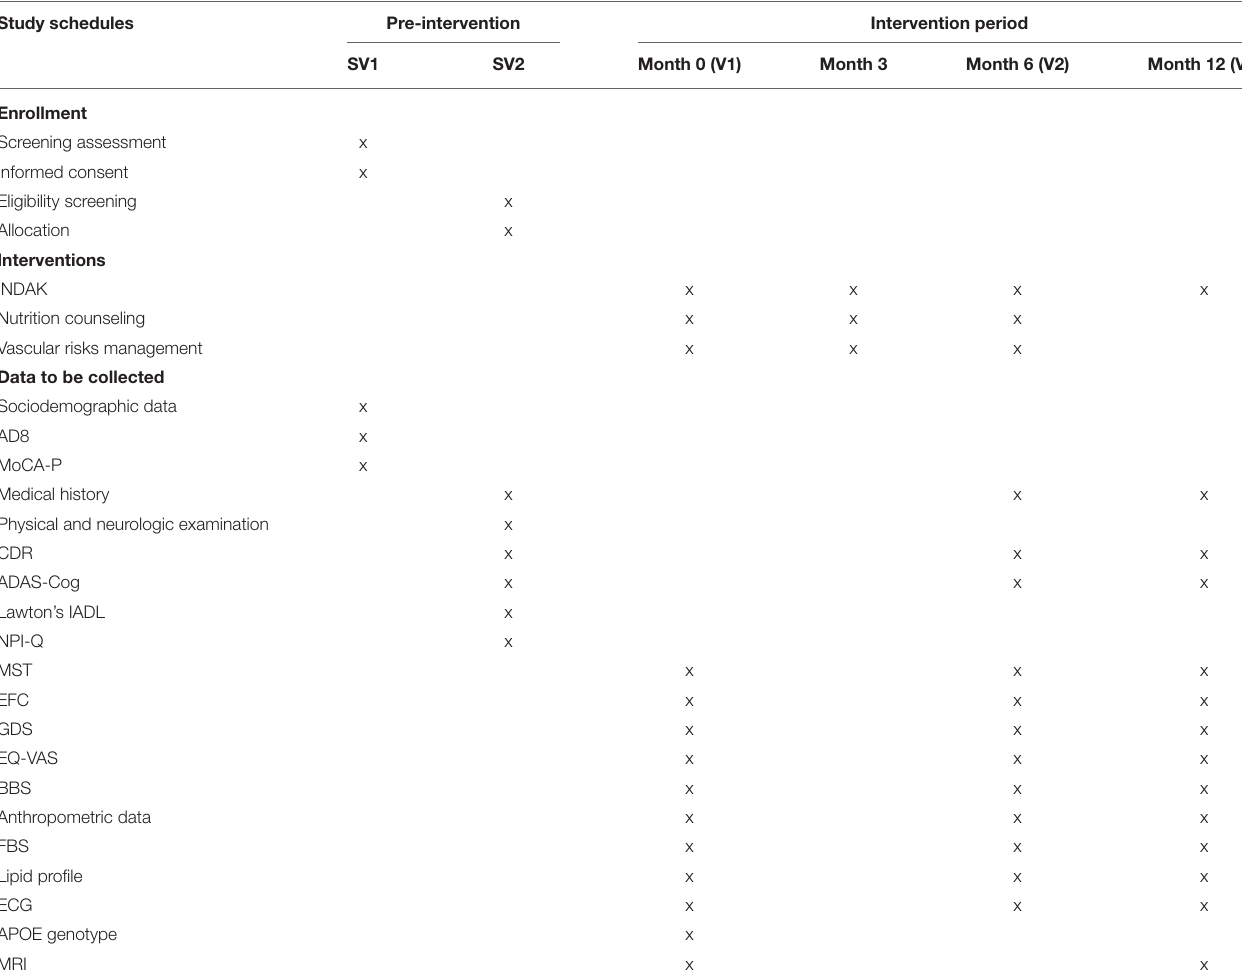
TABLE 1 | Schedule of enrollment, intervention, and data collection. Study